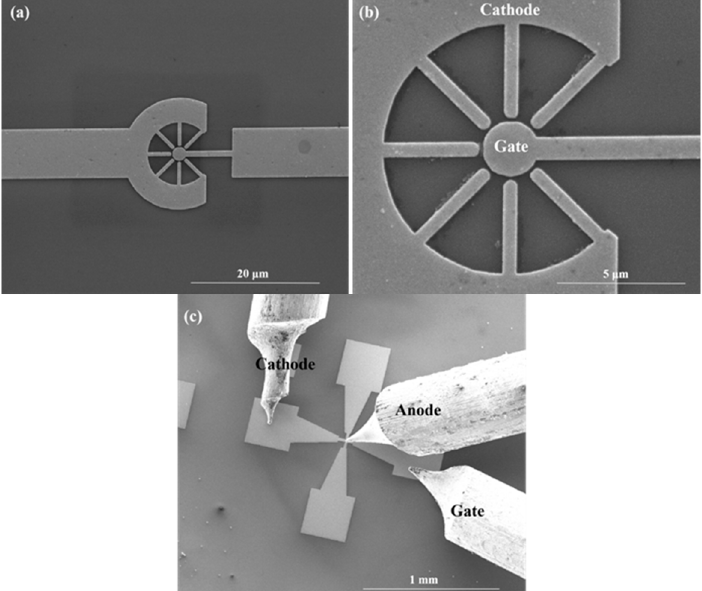
Figure 8 . SEM images of ( a ) a top view of a symmetrical NVC-based electron source, ( b ) zoom-in